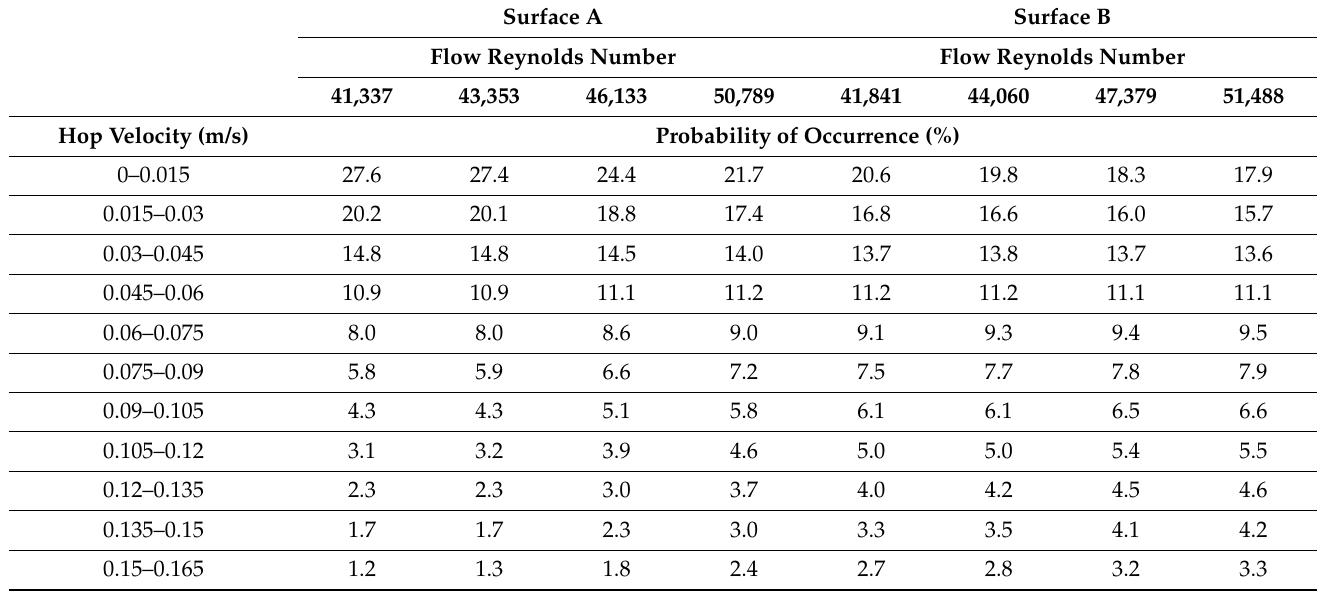
Table A6. The effect of different flow Reynolds numbers on the particle velocity exponential distribution model parameters, for bed surfaces A and B, for fixed particle density of 1132 kg/m 3 . These tabulated data correspond to the results plotted in Figure 15a,c.